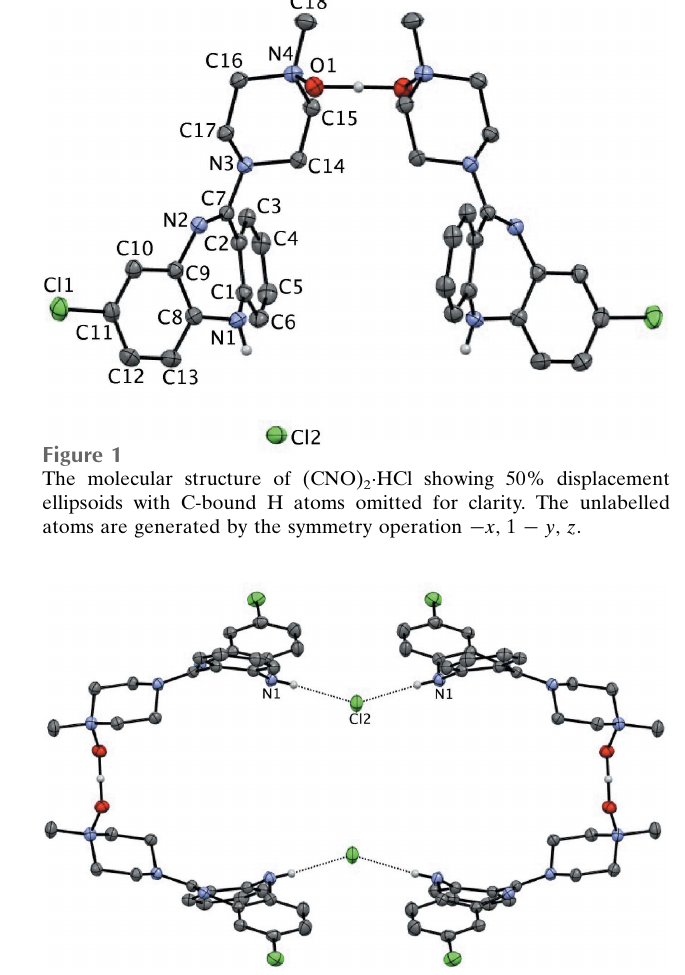
Figure 2 The cyclic tetramer (CNO) 4 (cid:2) (HCl)2 templated by N—H (cid:2)(cid:2)(cid:2) Cl hydrogen- bonding